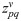
Curves of zpqν (p, q = 1, 2, ν ∈ Λ) in 3-dimensional space for synchronization case.